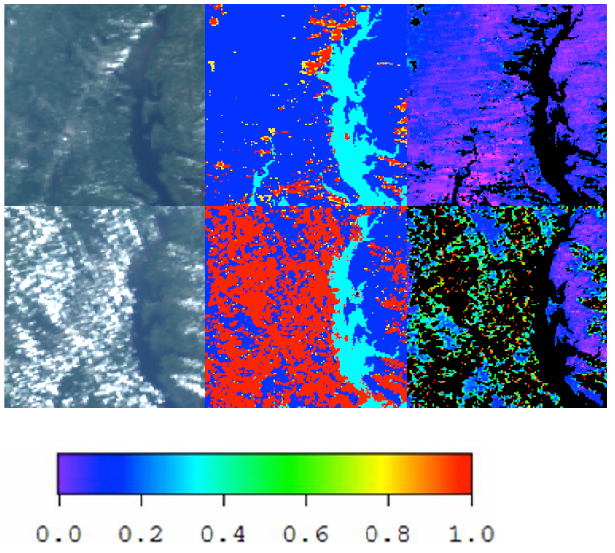
Figure 13. Similar to Fig. 12, but for MODIS sensor images from 10 July 2011, at the Terra overpass time of 15:30UTC (top) and at Aqua overpass of 18:50UTC (bottom).